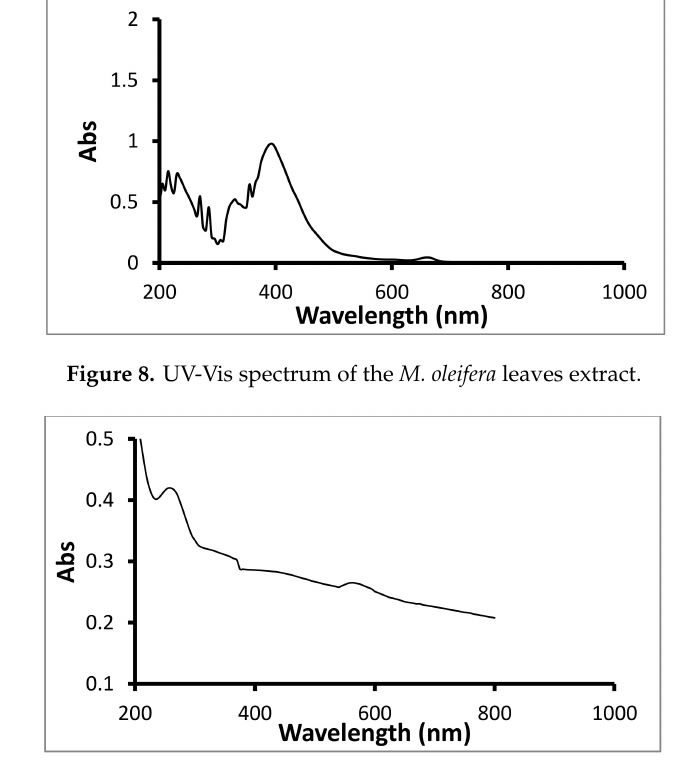
Figure 9. UV-Vis spectrum of the synthesized copper